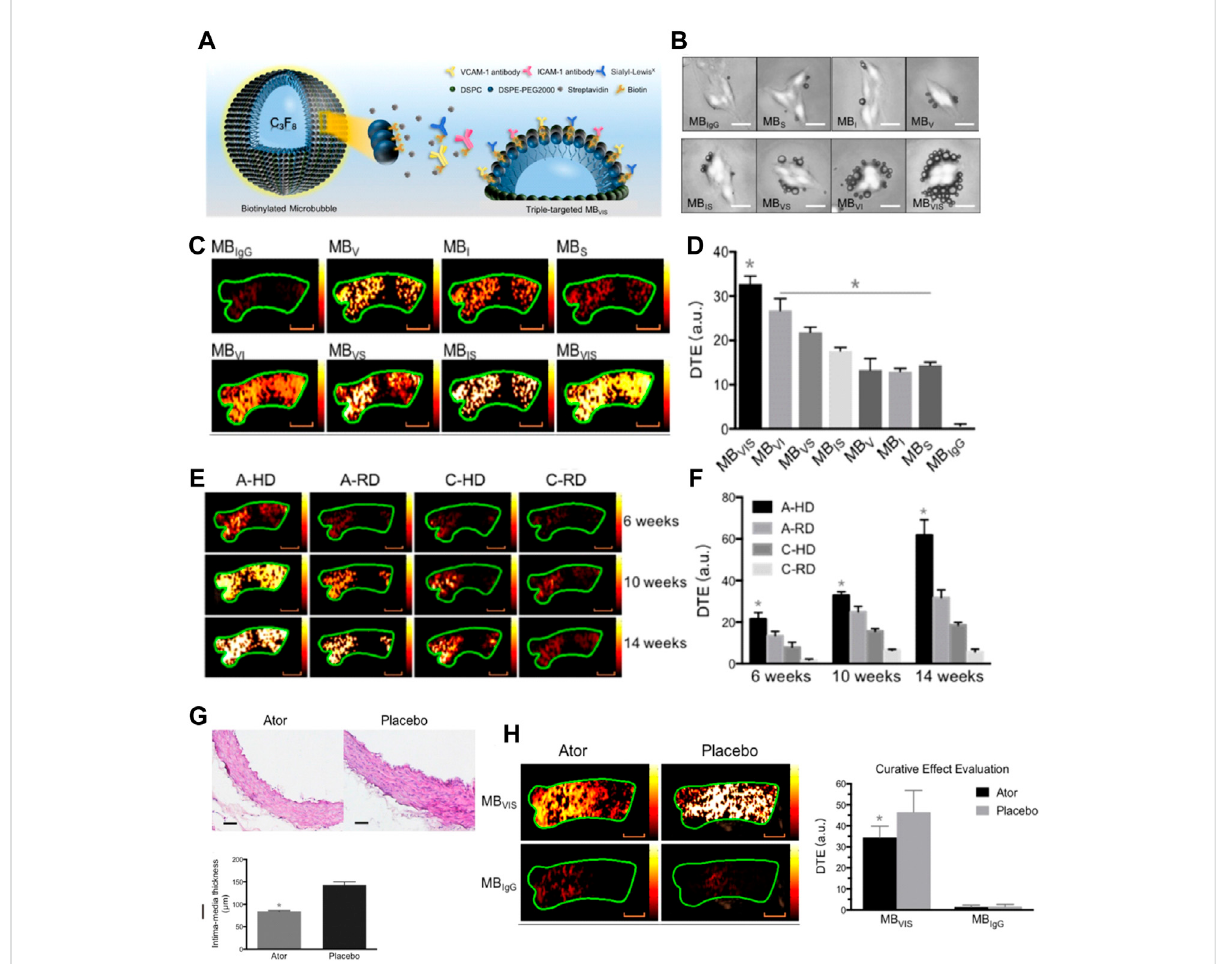
FIGURE 8 (A) DiagramoftargetedMB VIS . (B) Representativebright- fi eldmicrographsoftargetedMBsandMB IgG boundtostimulatedbEend.3cells(40 ng/ mlTNF- α ;scale bar=10 μ m). (C) Representative color-codedultrasoundimagesafter injectionofvarious kindsofMBsatthe10-weekfeedingtime, and (D) thequantitativeanalysisofultrasoundsignalintensities. (E) Representativecolor-codedimagesfromfourgroupsafterinjectionofMB VIS ,and (F) thequantitativeanalysisofultrasoundsignalintensities.Scalebar=1 mm. (G) RepresentativeH&Eimagesandquantitativeanalysisofintima- media thickness of ascending aorta sections from ApoE − / − mice-fed atorvastatin or placebo in their daily hypercholesterolemic diets for 8